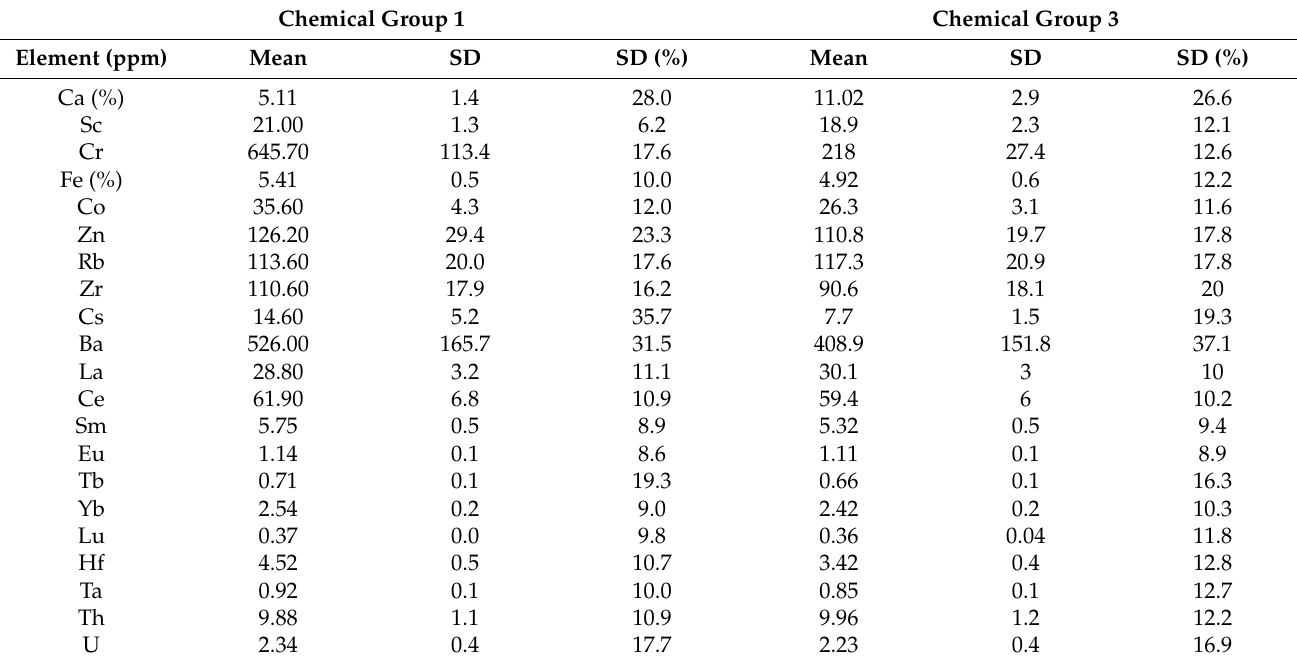
Table 3. Mean compositional concentrations for elements measured in Chemical Groups 1 and 3. All data are reported in ppm unless otherwise stated.